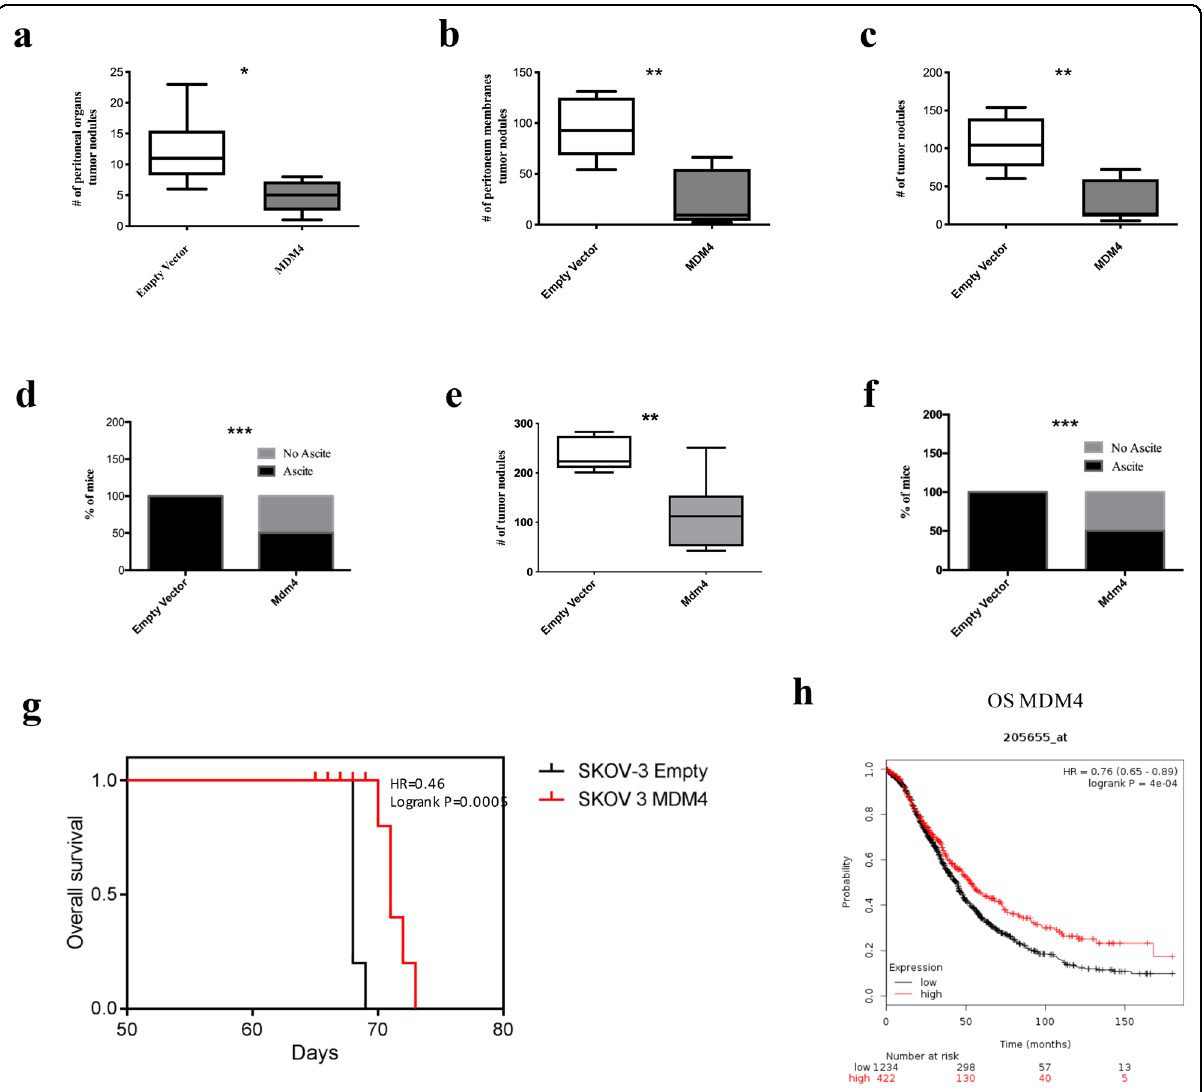
Fig. 1 MDM4 decreases ovarian cancer nodules dissemination and improves EOC patients ’ overall survival probability. a Number of nodules in peritoneal organs of Empty Vector or MDM4-SK-OV-3-injected mice ( n = 6, two-tailed Student ’ s t test, p = 0.018). b Number of peritoneum membranes nodules as in c ( n = 6, two-tailed Student ’ s t test, p = 0.0016). c Total number of nodules present in both peritoneal organs and peritoneum membranes ( n = 6, two-tailed Student ’ s t test, p = 0.0016). d Percentage of mice showing ascites at the fi nal time point ( n = 6, χ 2 test, p < 0.0001). e Total number of nodules in Empty Vector or Mdm4 -ID8 cells ( n = 6 for Empty Vector , n = 7 for Mdm4 , two-tailed Student ’ s t test, p = 0.0042). Nodules were counted blindly by two independent observers. f ID8 ascites analysis as in d ( n = 15, χ 2 test p < 0.0001). g OS in mice